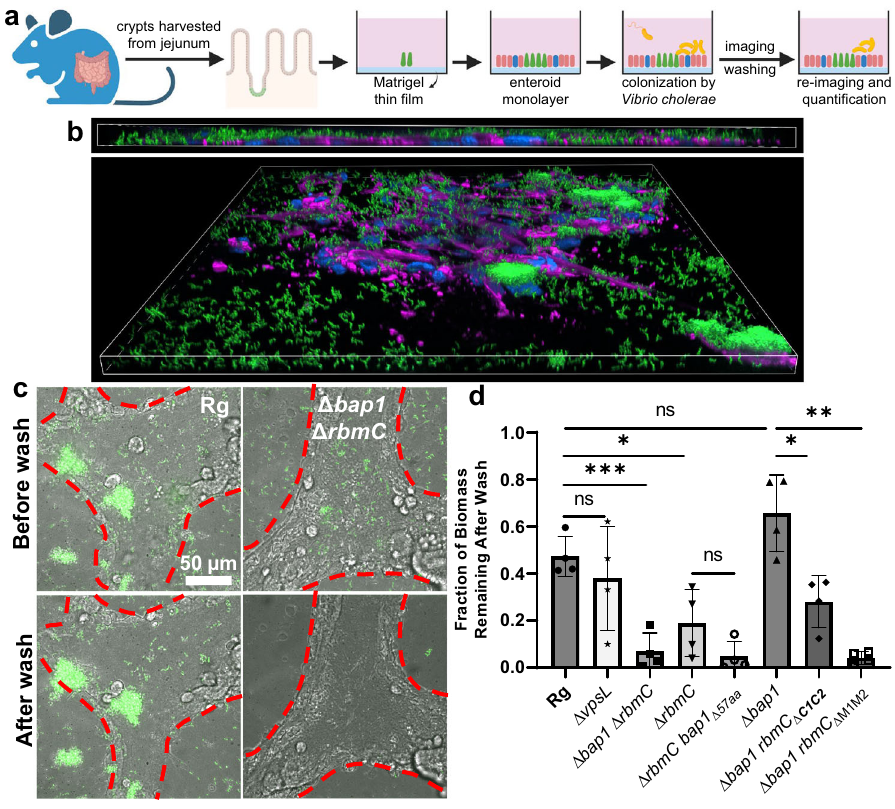
Fig. 5 | Bap1 and RbmC are required for colonizing enteroid monolayers. a Schematic for the growth of in vitro enteroid monolayers and subsequent colo- nization by V. cholerae cells. Created with Biorender.com. b Side ( Top ) and tilted view( Bottom )ofarepresentativemonolayerstainedwithDAPIandanF-actinprobe conjugated to fl uorescent Alexa Fluor TM 647 dye (magenta) and colonized by V. cholerae bio fi lmsfromarugose(Rg)strainconstitutivelyexpressingmNeonGreen. The total size of the view is 439×439×13 µ m. c Representative results of a mono- layer colonized by V. cholerae bio fi lms, before ( Top ) and after ( Bottom ) washing,